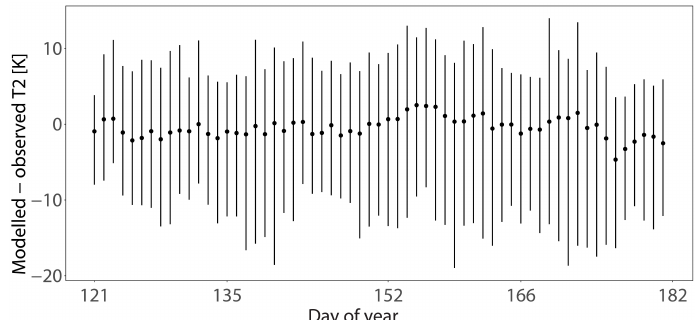
Figure 1. Min, max and median values (black dots) for modeled—observed hourly T2, summarized for each day and all stations.